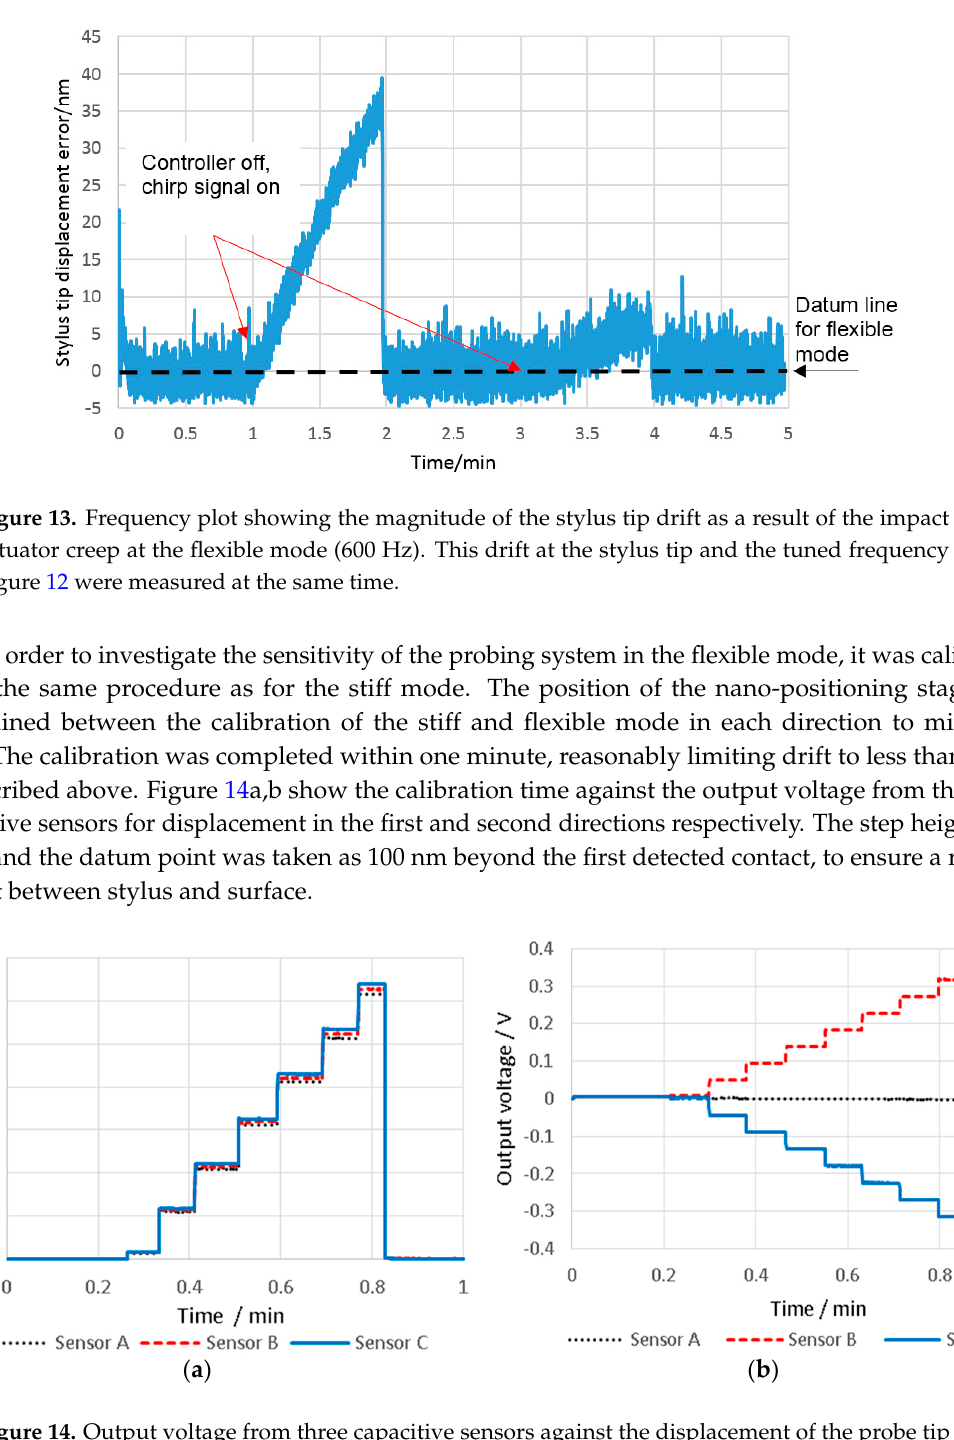
Figure 12. Frequency plot illustrating how actuator drift reduces following a series of actuator load cycles.